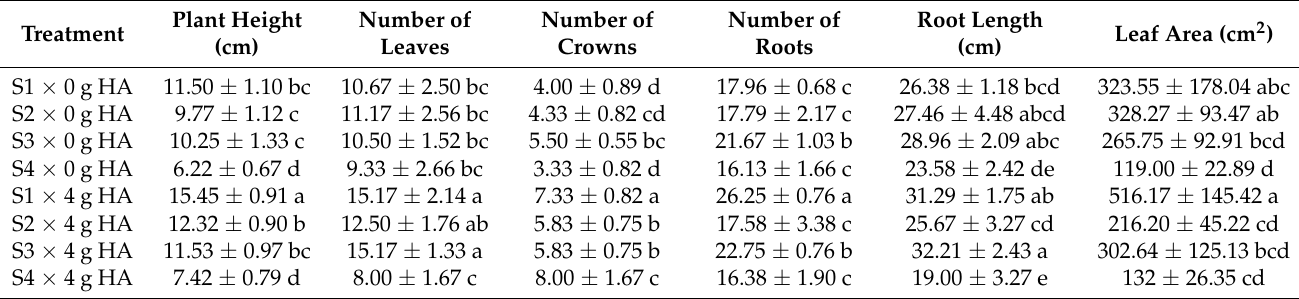
Table 4. Effect of substrate and humic acid on the morphological performance of ‘Aroma’ strawberry plants during acclimatization.